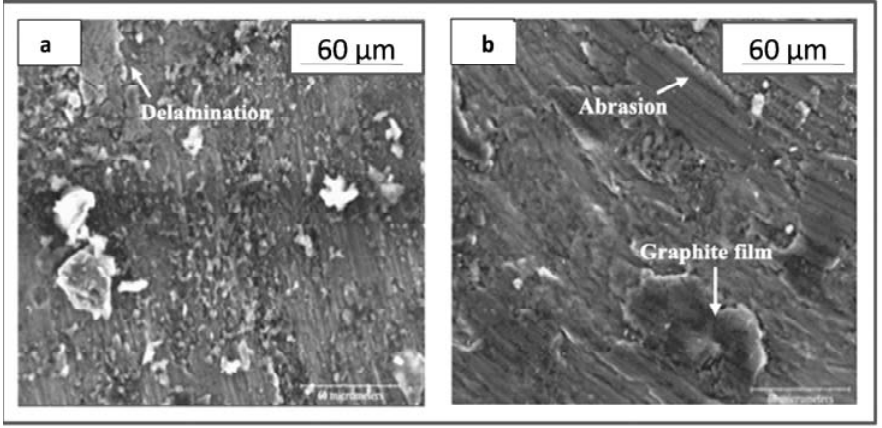
Fig. 8. SEM micrographs of the worn surfaces of a) Al/2SiC and b) Al/2SiC/5Gr nano-composites adapted from